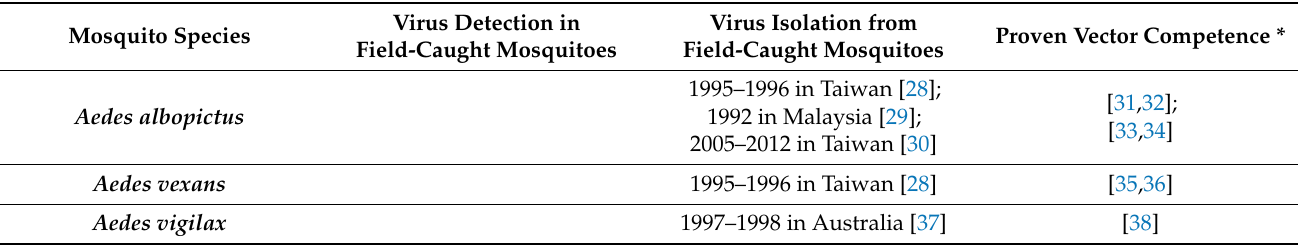
Figure 2. Distribution of reports on JEV detection and isolations from field-caught mosquitoes of the confirmed vector species Ae . albopictus , Ae . vexans , Ae . vigilax , Ar . subalbatus , Cx . annulirostris , Cx . bitaeniorhynchus , Cx . fuscocephala , Cx . gelidus , Cx . pipiens , Cx . pseudovishnui , Cx . quinquefasciatus , Cx. sitiens , Cx . tritaeniorhyncus and/or Cx . vishnui . Table 1. Confirmed JEV mosquito vector